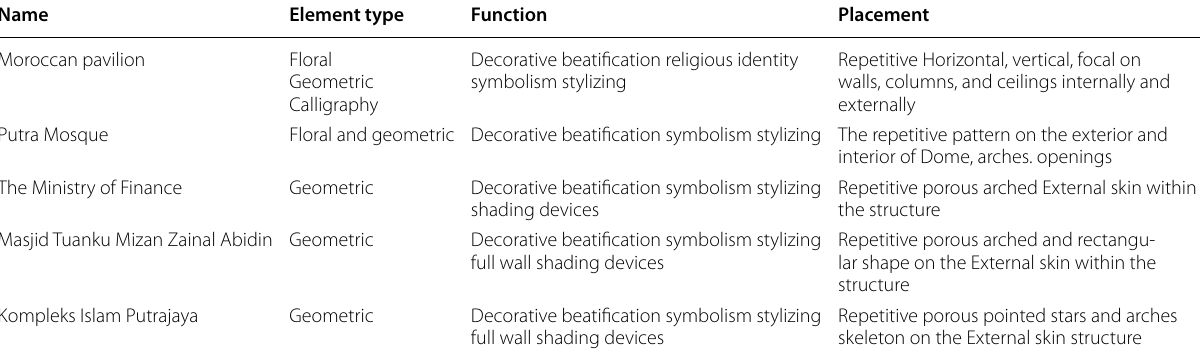
Table 2 Analysis of the five selected case